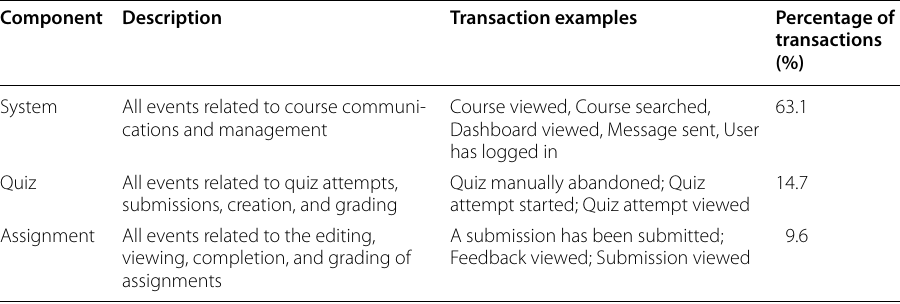
Table 2 Descriptions of the System, Quiz, and Assignment Moodle components Component